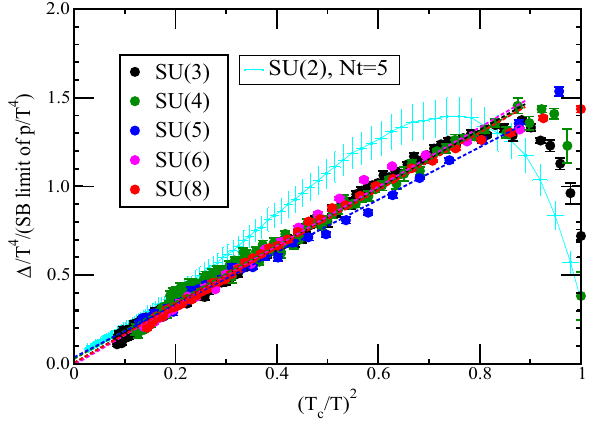
Fig. 21 Comparison of the trace anomaly in the deconfined phase with Ref. [16]